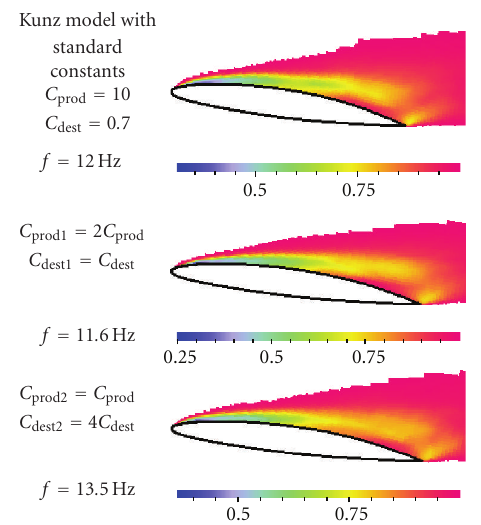
Figure 11: Influence of the empirical constants on the oscillation frequency and the shape of the time-averaged cavity ( L/c = 0 . 8).